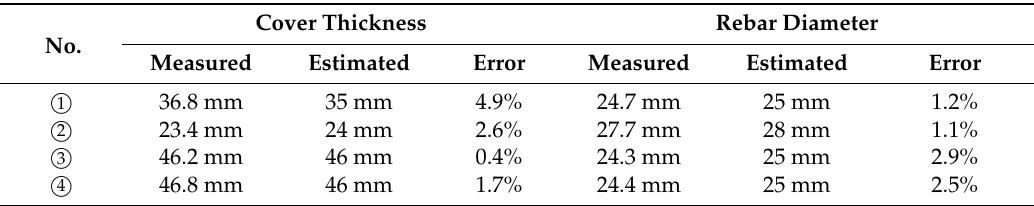
Table 2. Estimated and measured rebar diameters and cover thicknesses and their relative errors in the field